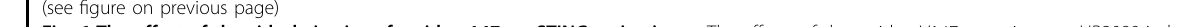
Fig. 6 The effect of the sidechain size of residue 147 on STING activation. a The effects of the residue V147 mutations on HB3089-induced expression of the ISG reporter. Data are presented as the means ± SD of triplicate experiments, signi fi cance is determined with One-Way ANOVA test; ns, not signi fi cant, **** P < 0.0001. b The effects of the residue V147 mutation on the translocation of STING using confocal immuno fl uorescence assay. 293 T cells were stained with anti-STING to label STING (red), anti-GM130 (green) to label Golgi, and DAPI (blue) to label the nuclei. Scale bar: 10 μ m. Representative images were shown from three independent experiments. c Schematic summarizing STING activation mechanism shared by HB3089 and SAVI-related mutant V147L. The connector helix senses the STING-activating signal including HB3089 binding (oval) or SAVI mutation (star) and rotates driving by the steric hindrance of the connector residues, which eventually leads to the signi fi cant contraction of the LBD and the conformational changes, especially TM1 revolution, of the TMD for STING activation. The connector and transmembrane helices in the inactive state are colored by grey for both monomers, while they are colored by blue and green for monomers